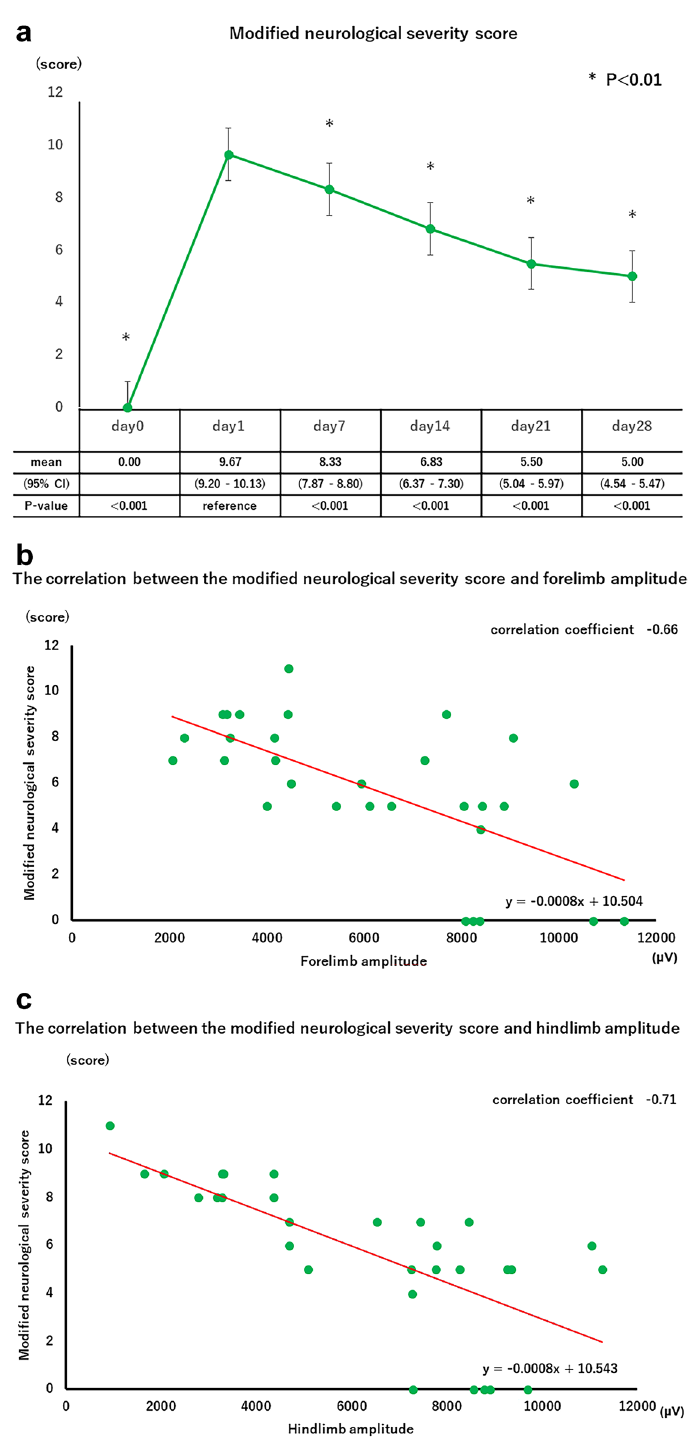
Figure 3. ( a ) Time course of mNSS after MCAO procedure. Repeated measures analysis of variance was performed on the weekly measurements. Student-t tests with Bonferroni correction were performed for outcomes with significant one-way analysis of variance. *P < 0.01. ( b ) Bivariate analyses of mNSS scores and the amplitudes of tcMEPs in forelimbs. ( c ) Bivariate analyses of mNSS scores and the amplitudes of tcMEPs in